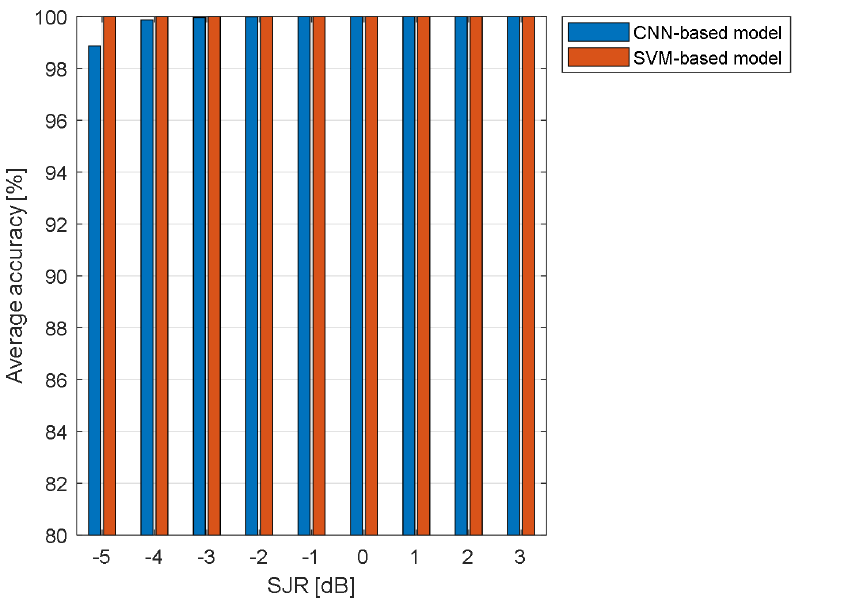
Figure 12. Results of the proposed SVM-Based and CNN-based classification methods when Mux-LG modes are